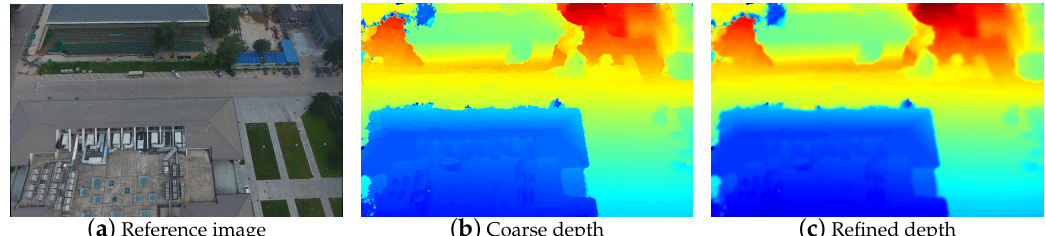
Figure 2. Visualization of the depth map estimated by the learning-based MVS method. ( a ) The input image. ( b ) Depth estimation by R-MVSNet [6]. ( c ) Refined depth by bilateral